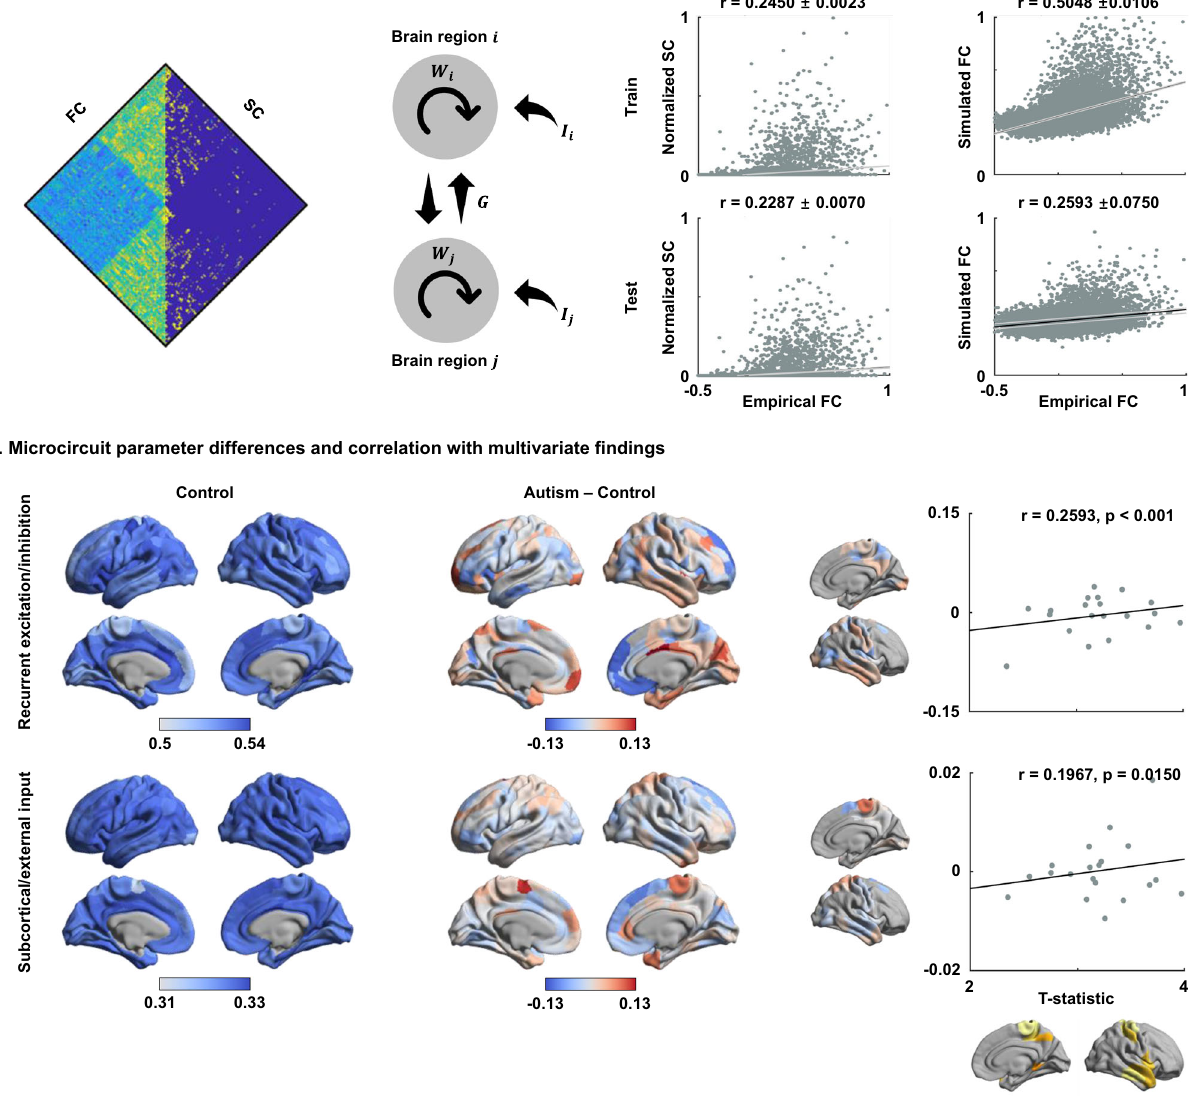
Fig. 2 Microcircuit parameters and associations with macroscale fi ndings. a A relaxed mean- fi eld model 18 was used to predict functional connectivity (FC) from structural connectivity (SC) and to estimate region-speci fi c microcircuit parameters, i.e., recurrent excitation/inhibition W i and subcortical/ external input I i (left). A global coupling constant G is also estimated. Linear correlations between FC and SC, and empirical and simulated FC are shown (right). Black lines indicate mean correlation and gray lines represent 95% con fi dence interval across cross validation. b Microcircuit parameters of controls (left) and differences of the parameters between individuals with autism and controls (middle). Linear correlations between t -statistics derived from the multivariate group comparison and the regional changes in microcircuit parameters are reported, constrained to regions showing signi fi cant between-group differences in Fig. 1c (right). Source data are provided as a Source Data fi group differences for the thalamus (FDR = 0.03), caudate (FDR = 0.04), and cerebellum (FDR = 0.03), indicating that the low dimensional representation of subcortico-cortical connectivity patters of these regions changed in autism (Supplementary Fig. 7).